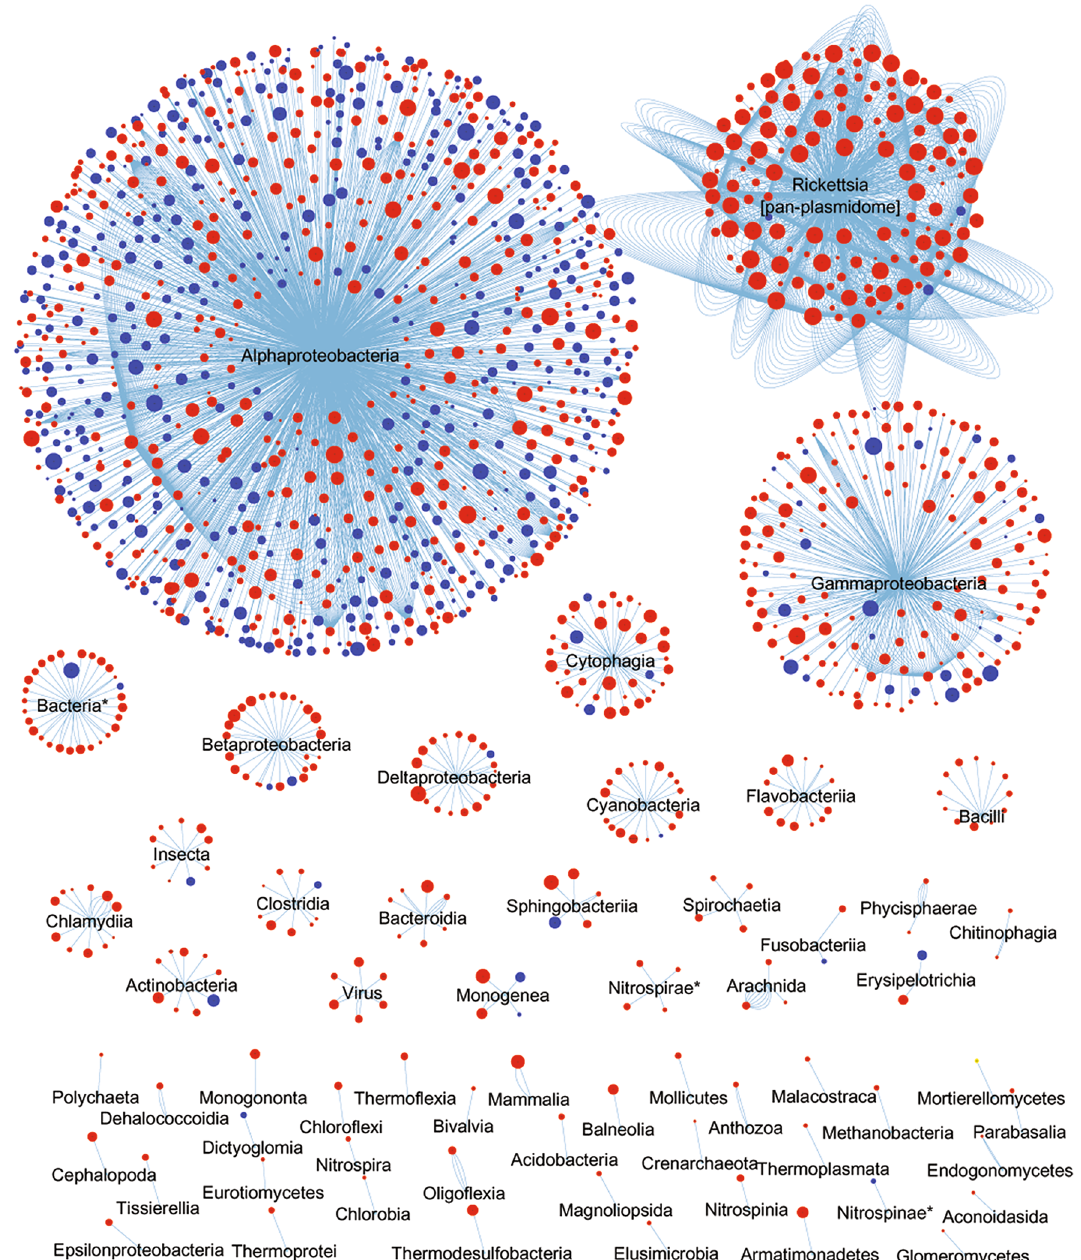
Figure 6. Evolutionary network of the Rickettsia pan-chromosome displaying best homologues from the Rickettsia pan-plasmidome and customised databases containing non- Rickettsia protein sequences of bacteria, archaea, eukarya and viruses. Nodes correspond to the pan-chromosome cRiGs. Node colours correspond to the core (in blue) or flexible (in red) cRiGs. Node sizes refer to sequence identities (from 30 to 100%) between a cRiG and its first best homologue, which are linked by blue edges. * unclassified